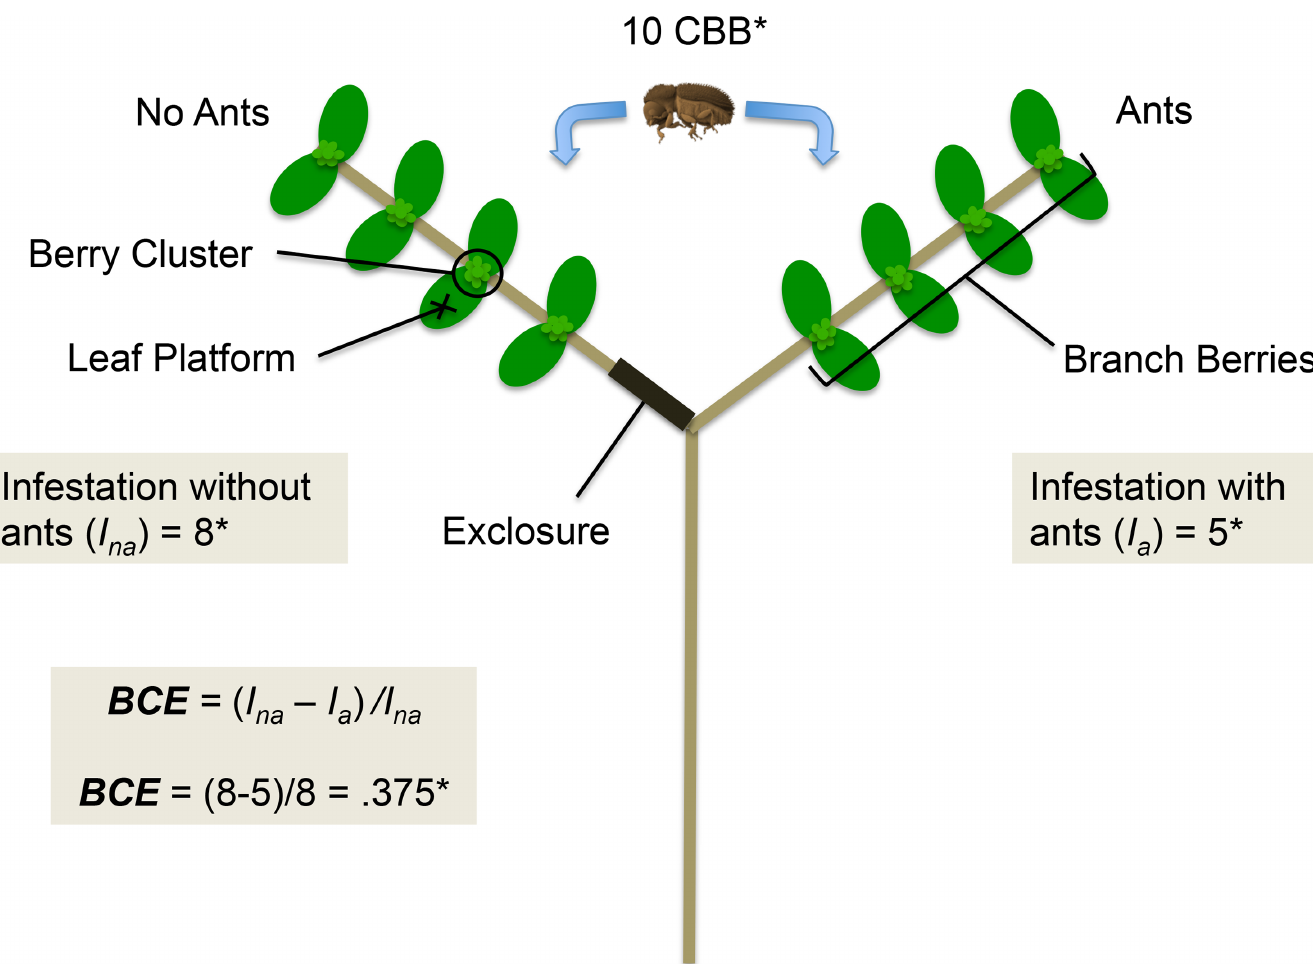
Fig 2. Exclosure experimental design. Shows paired-branch treatment design and calculation of biocontrol efficiency (BCE). Infestation was measured as the number of bored coffee fruits on branches 24 hrs after coffee berry borer placement. Total coffee berries per branch, leaf platforms, and berry clusters near leaf platforms are illustrated. This design was repeated on four different branch pairs within each coffee bush replicate, at different times, using four levels of CBB density. Asterisks indicate data is hypothetical and is only intended for the purpose of demonstrating the BCE calculation.